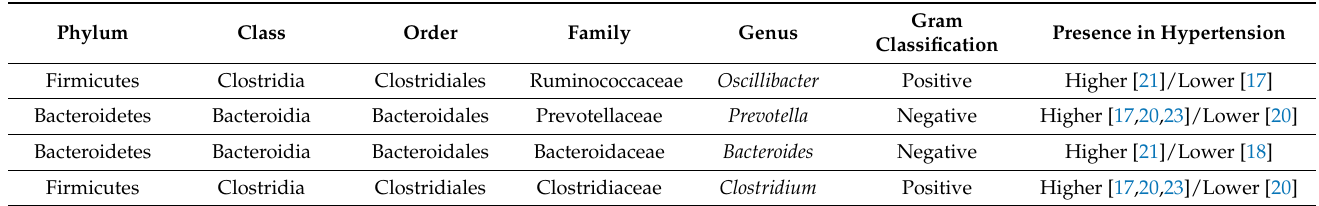
Table 3. List of phylum, class, order, family, genus and gram classifications in bacteria for which researchers have obtained different results in healthy and hypertensive